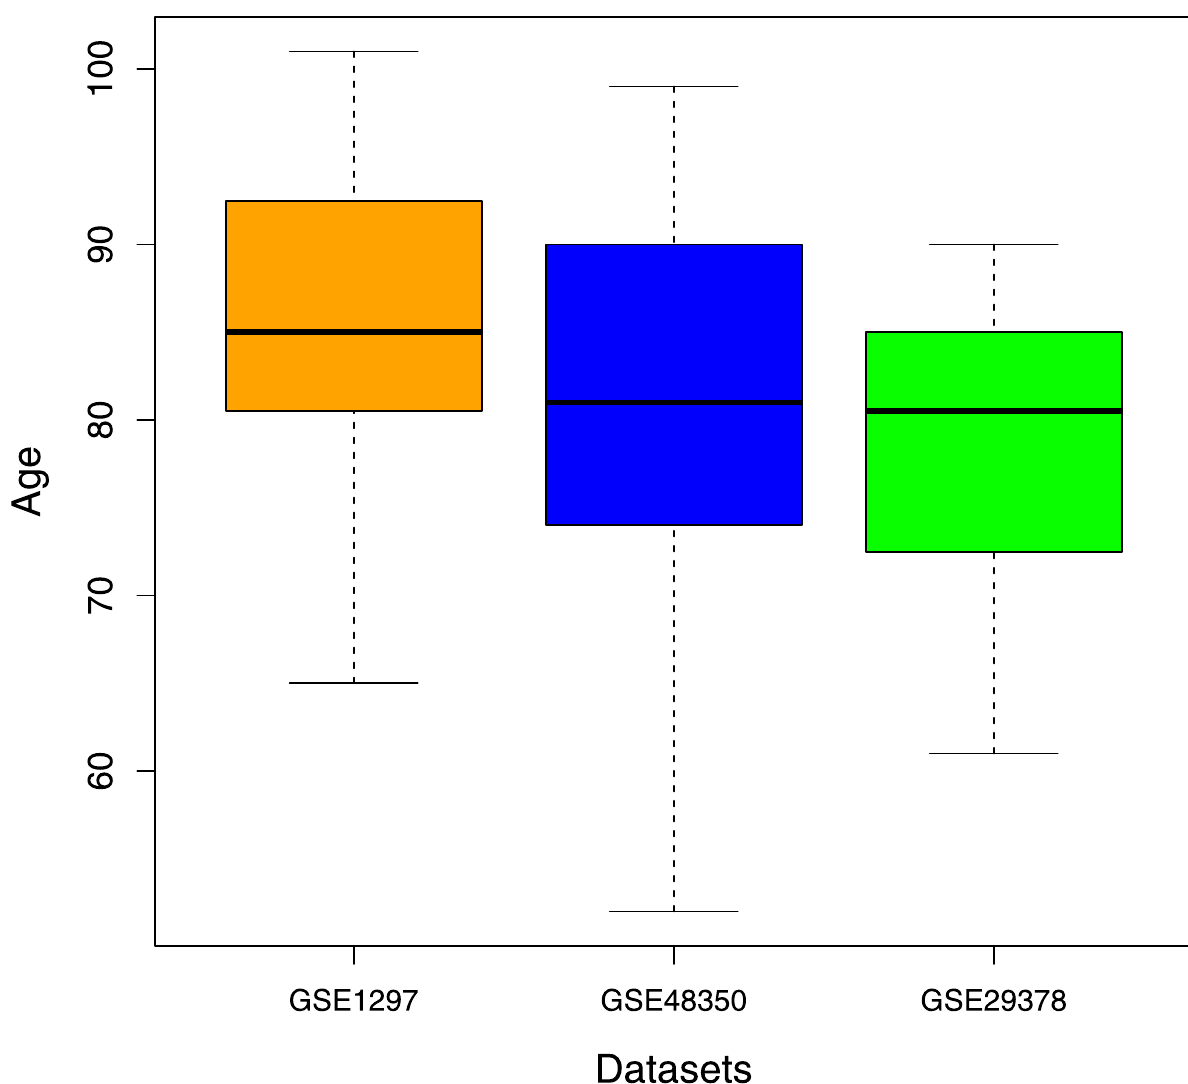
Fig 15. Age distributions of the three datasets analyzed. To make the three distributions comparable we did not consider 17 samples of young subjects in the database